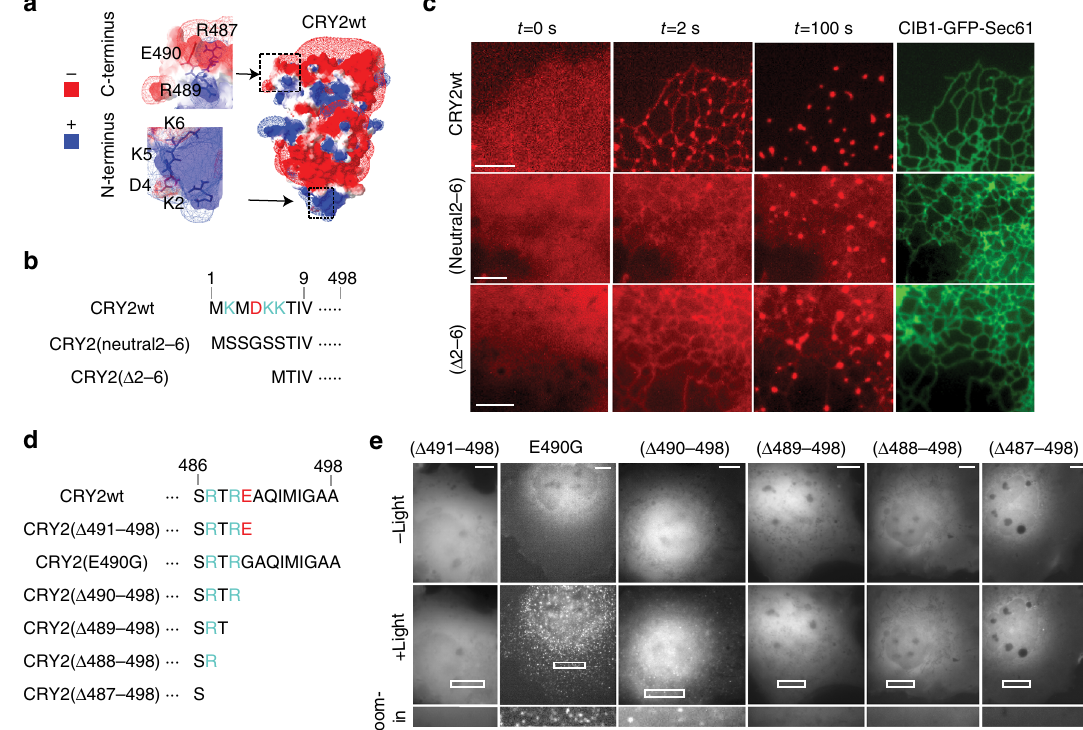
Fig. 1 Electrostatic charges at N- and C-termini are important for CRY2 – CIB1 and CRY2 – CRY2 interactions, respectively. a Surface charge distribution of CRY2wt predicted by homology modeling. Charged residues are labeled in the insets of both the N-terminus and C-terminus. b Electrostatic charges at the N-terminus of CRY2 are removed by having charged amino acids replaced with neutral ones (CRY2(neutral2 – 6)) or deleted (CRY2( Δ 2 – 6)). c The light- induced CRY2 – CIB1 binding is much weaker for CRY2(neutral2-6) or CRY2( Δ 2 – 6), as compared to CRY2wt. COS7 cells were co-transfected with CIB1- GFP-Sec61 and each mCh-tagged CRY2, respectively. Blue light was delivered at 2-s intervals for 100 s. d The amino acid sequences for the C-terminus of CRY2wt, CRY2(E490G) and each truncated CRY2. Truncated CRY2 variants, including CRY2( Δ 491 – 498), CRY2( Δ 490 – 498), CRY2 ( Δ 489 – 498), CRY2( Δ 488 – 498) and CRY2( Δ 487 – 498), were constructed by sequentially removing residues from CRY2(487 – 490). e Cytosolic CRY2 (E490G) and CRY2( Δ 490 – 498) formed clusters upon light stimulation, while the other C-terminally truncated derivatives did not. COS7 cells were transfected with each mCh-tagged CRY2 and stimulated with blue light at 5-s intervals for 500 s. Scale bars , 5 µ m ( c ), 10 µ m ( e